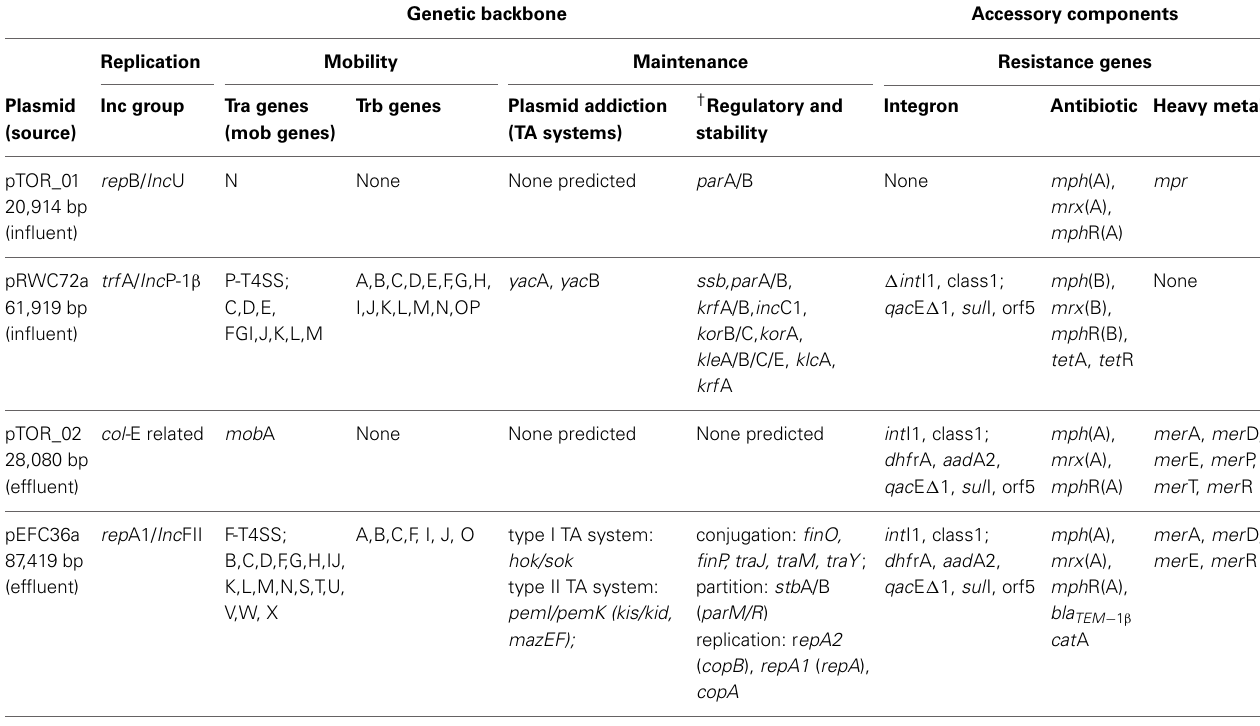
Table 1 | Summary characterization and comparison of plasmid backbones and accessory